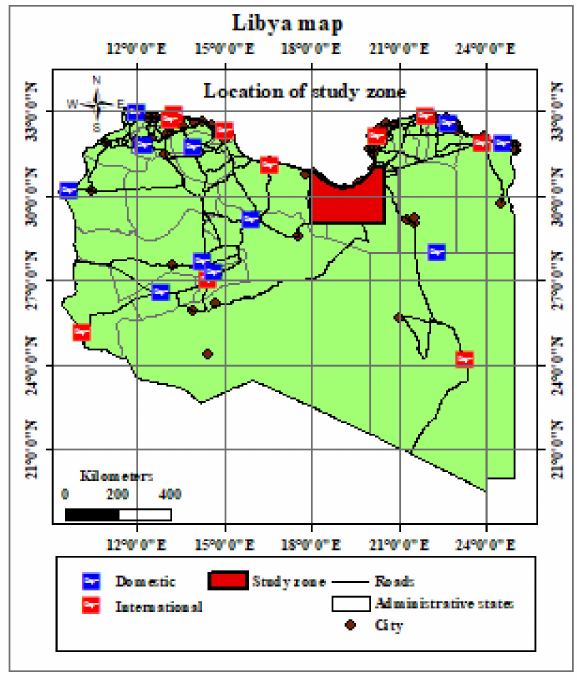
Figure 1. Location of the study